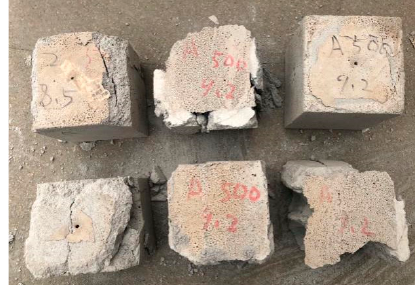
Figure 4. Foam concrete samples. Table 3. The mechanical properties of the concrete.